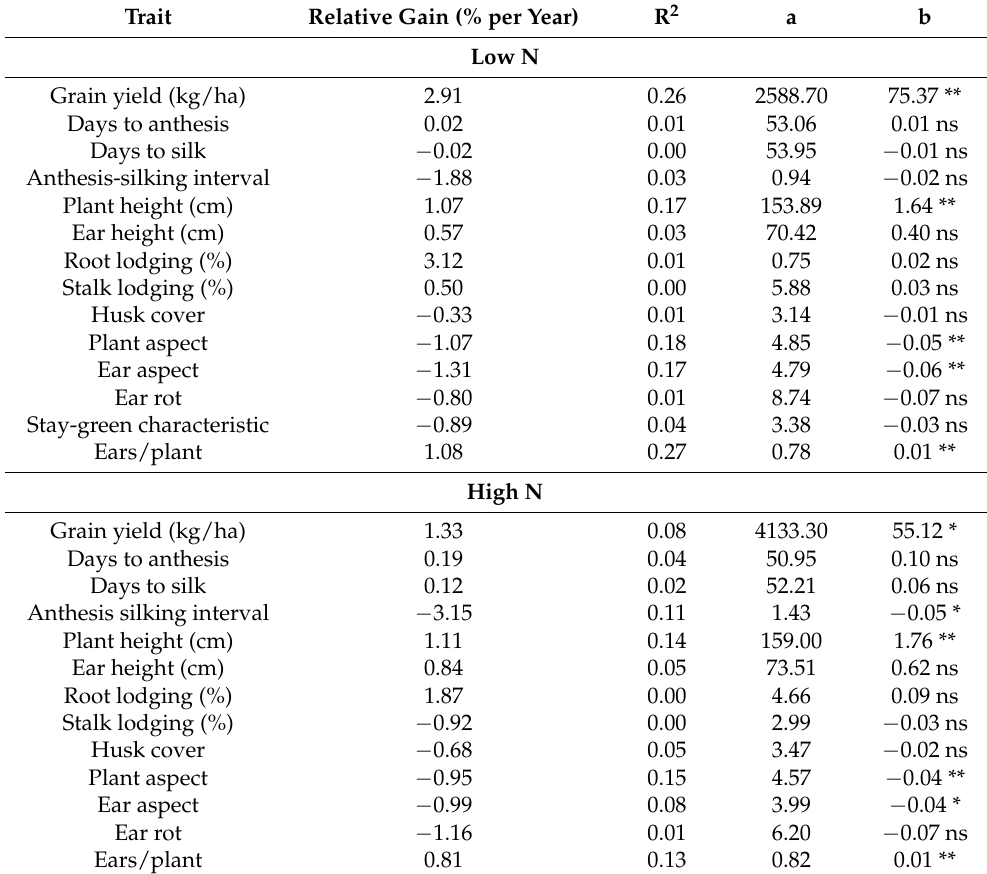
Table 3. Relative genetic gain, coefficient of determination (R 2 ), slope (a) and regression coefficients (b) of grain yield and other agronomic traits of early-maturing maize hybrids during three breeding periods under low N in four environments and high N in five environments in Nigeria from 2017 to